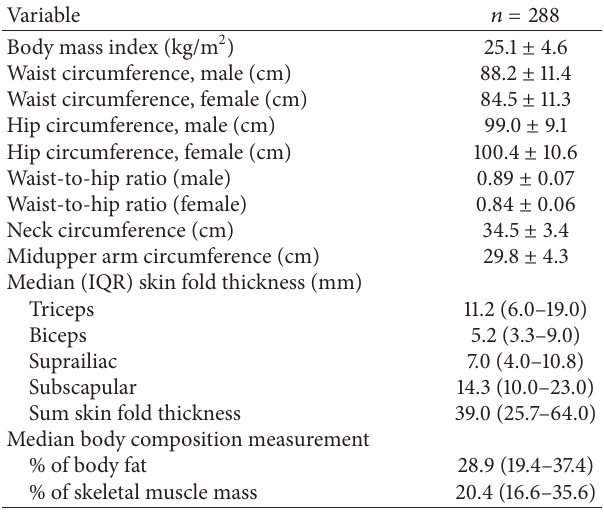
Table 1: Sociodemographic and HIV related characteristics of the study participants.